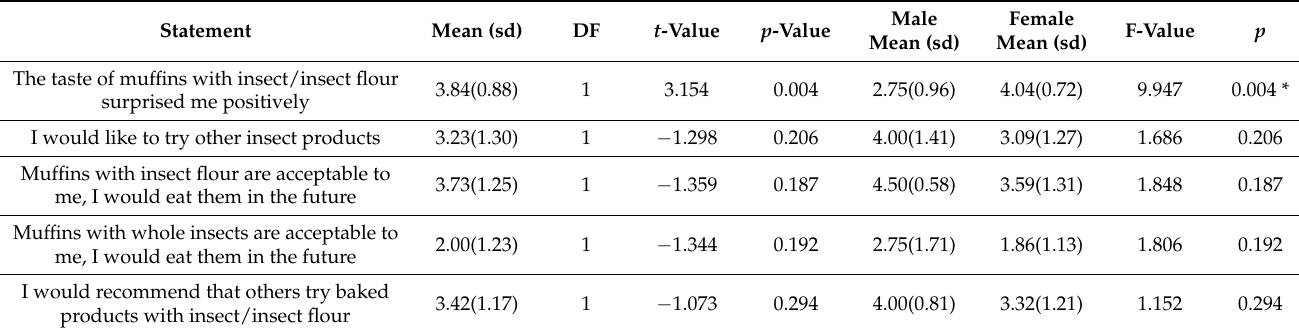
Table 6. Results of statements after the sensory evaluation of the muffins (1 = strongly disagree; 5 = strongly agree) on the total sample and by